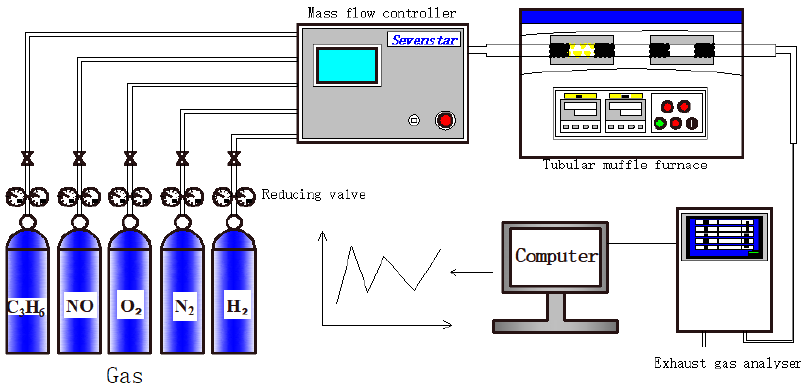
Figure 10. Soot combustion test platform.